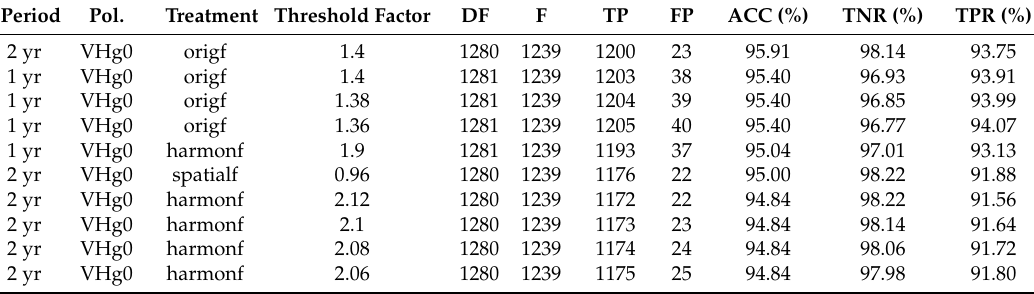
Table 6. Final results of the ALT detection (only the 10 best results in terms of global accuracy showed). DF = Number of deforested TS; F = Number of forest TS; TP = True positives; FP = False positives; TPR = True Positive Rate; TNR = True Negative Rate; ACC = Global Accuracy. Period Pol. Treatment Threshold